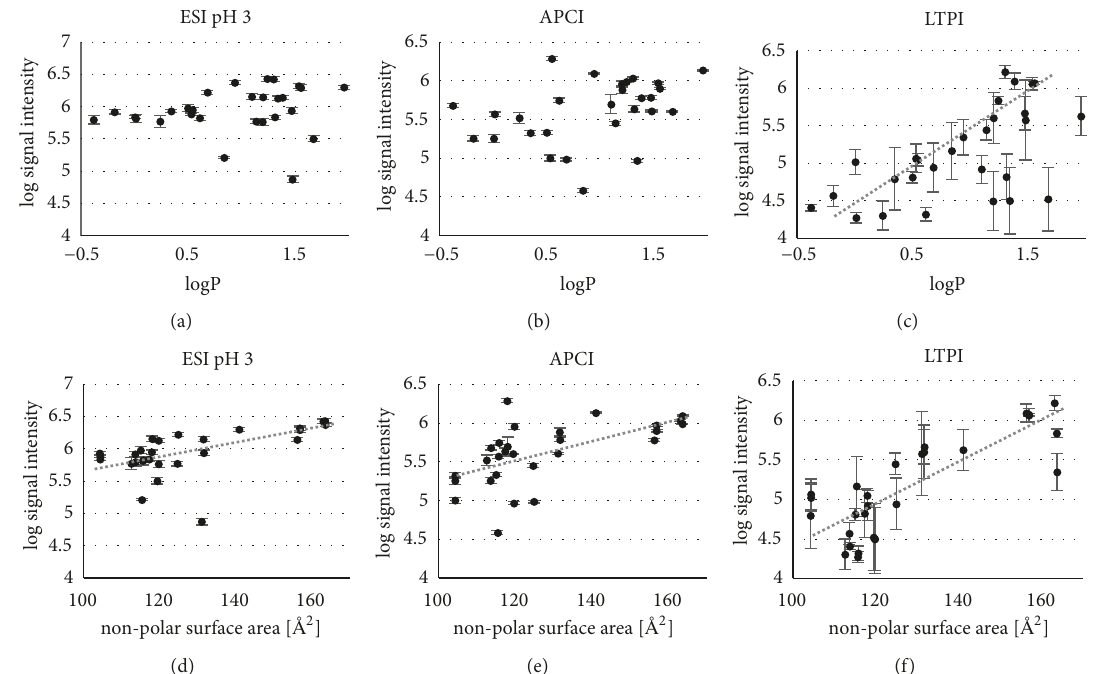
Figure 9: Log signal intensity (peak height) in dependency on the partition coefficient logP (SciFinder) for (a) ESI pH = 3, (b) APCI and (c) LTPI and the nonpolar surface area for (d) ESI pH = 3, (e) APCI, and (f) LTPI ((c) and (f) reprinted with permission from Springer [129]